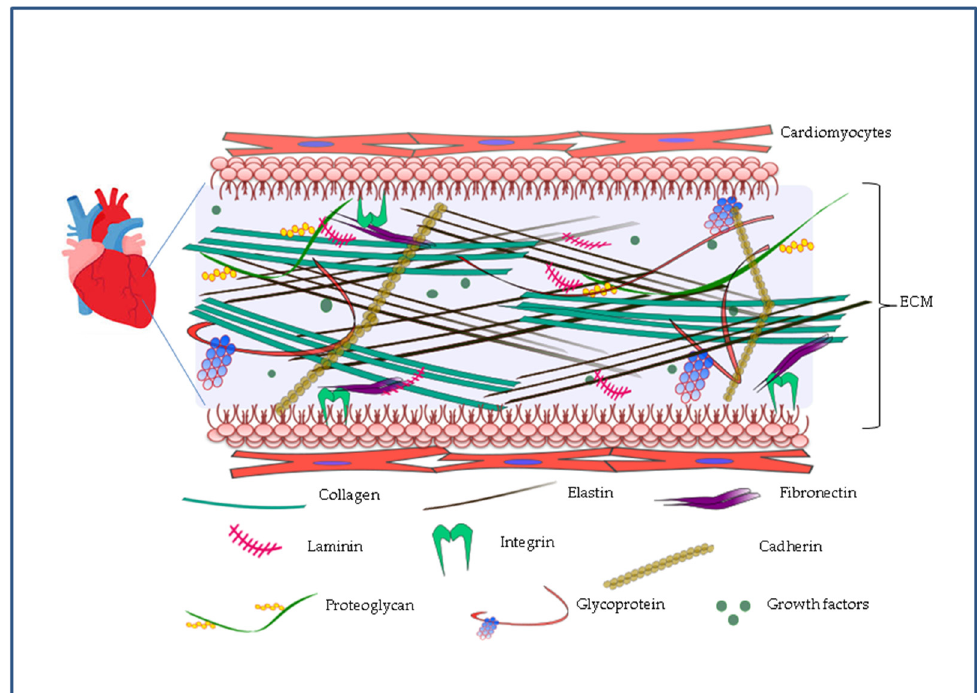
Figure 1. Representation of the complex tridimensional structure of the cardiac extracellular matrix (ECM). ECM is made of a dense network of proteins such as elastin, collagens, proteoglycans and glycoproteins. Through proteins such as fibronectins, laminins, cadherins and integrins, ECM plays a key role in cellular functions such as cell adhesion and growth thanks to the presence of soluble substances including growth factors.